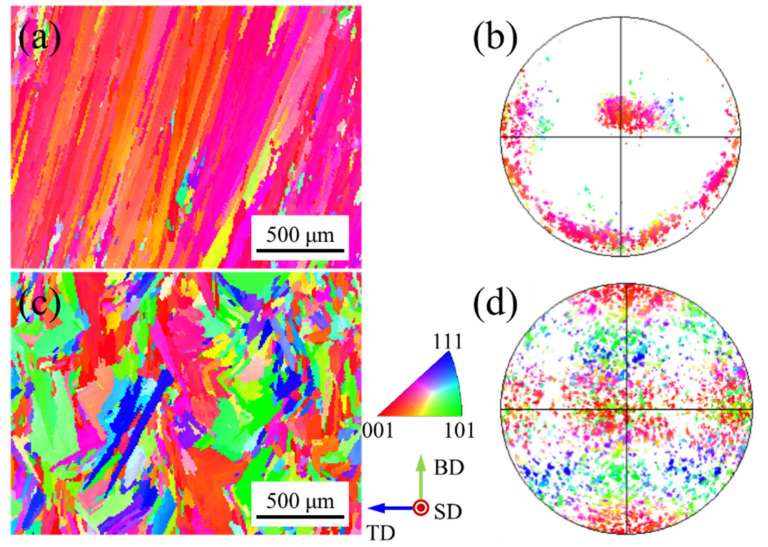
Figure 7. Inverse pole figure (IPF) maps and corresponding pole figure with different pulse period: ( a , b ) 30 ms; ( c , d ) 100